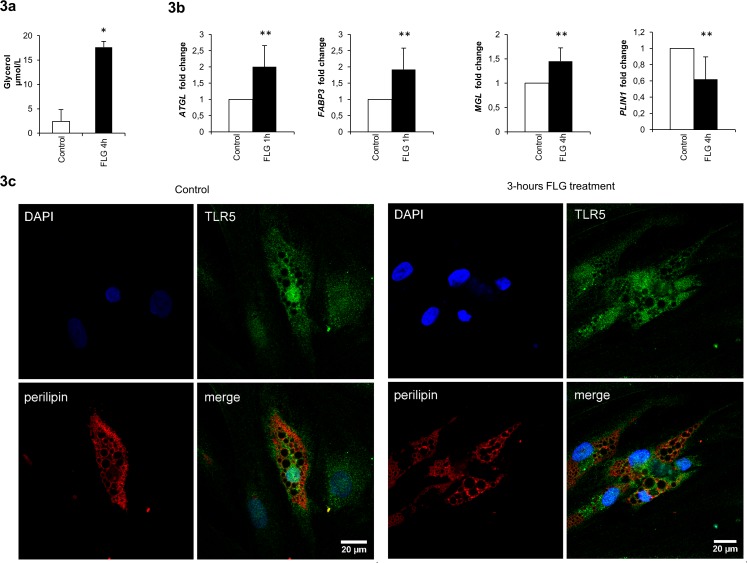
Glycerol is secreted from adipocyte lipid droplets due to increased lipolysis in response to flagellin treatment.(A) Adipocytes were treated with FLG for 3 hours and glycerol was measured from the cell culture media. The values are means + SD (n = 4). * indicates a p-value of <0.05. (B) Adipocytes were treated with FLG for 1 and 4 hours and changes in the expression of ATGL, PLIN1, FABP3 and MGL mRNA were determined. The values are means + SD (n = 4). ** indicates a p-value of <0.001. The results were normalized to GAPDH and the fold changes were calculated with the ΔΔCt method. (C) Adipocytes with and without 3-hours FLG treatment were labeled with TLR5 and perilipin antibodies, and imaged with confocal microscope. Compared to 30% in control cells, in 70% of FLG-treated adipocytes degradation of lipid droplets membranes was observed (perilipin-labeling in red). In mature adipocytes TLR5 is mainly located in intracellular pool near lipid droplets and nuclei without co-localization, and only a minority on cell membranes.